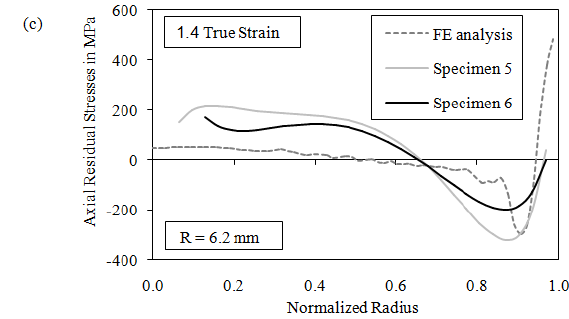
Figure 10. The comparison of the results of the contour method and FEA (Initial radii are 12.5 centimeters) Figure 10(c) illustrates the results obtained from